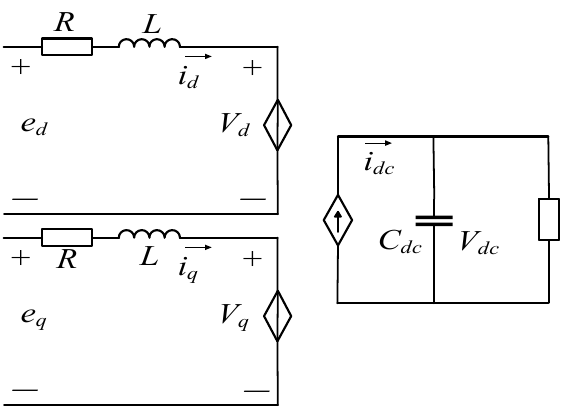
Figure 5. The converter’s model in the dq synchronous rotating coordinate system (the vector E of the grid electromotive force as the reference direction).